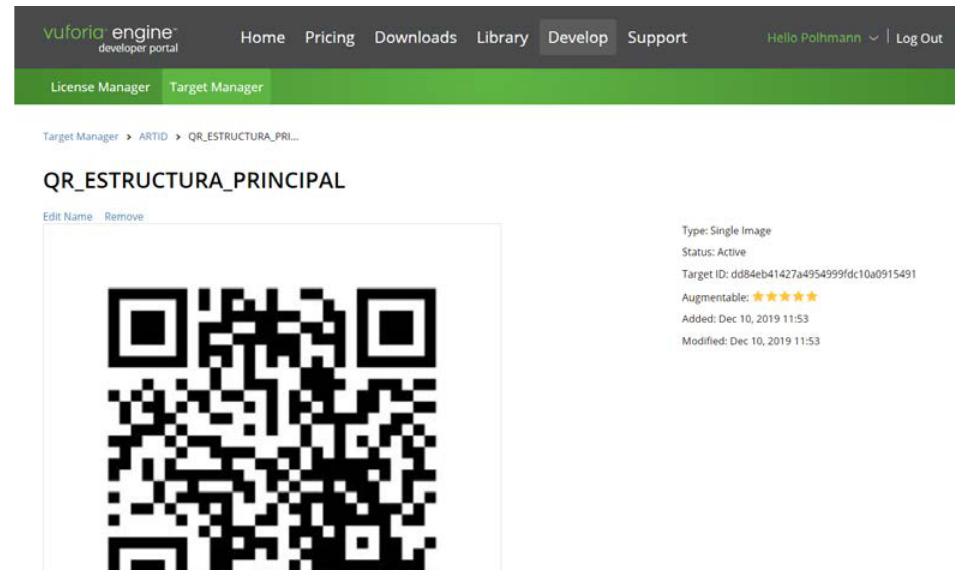
Figure 5. Screenshot of the Vuforia software.